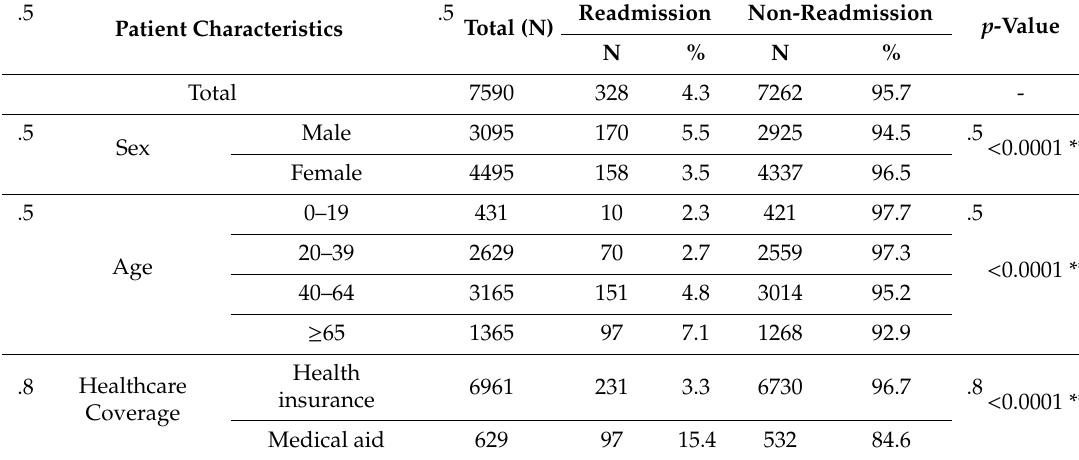
Table 1. Demographic and clinical characteristics of coronavirus disease (COVID-19) readmission patients.